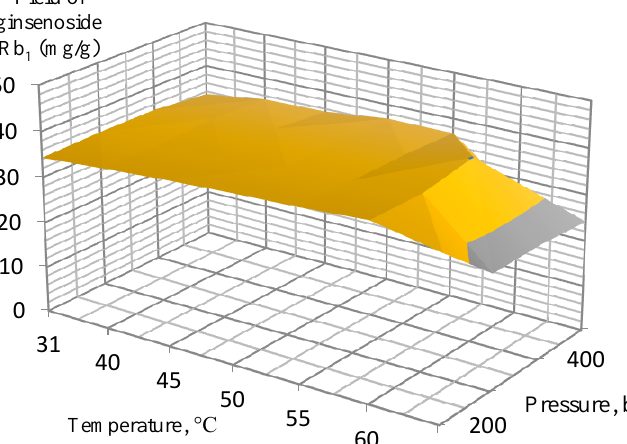
Figure 1. Orthogonal projection representing the results of extraction of ginsenoside Rb 1 at a 200 to 500 bar and 3.4% EtOH co-solvent.